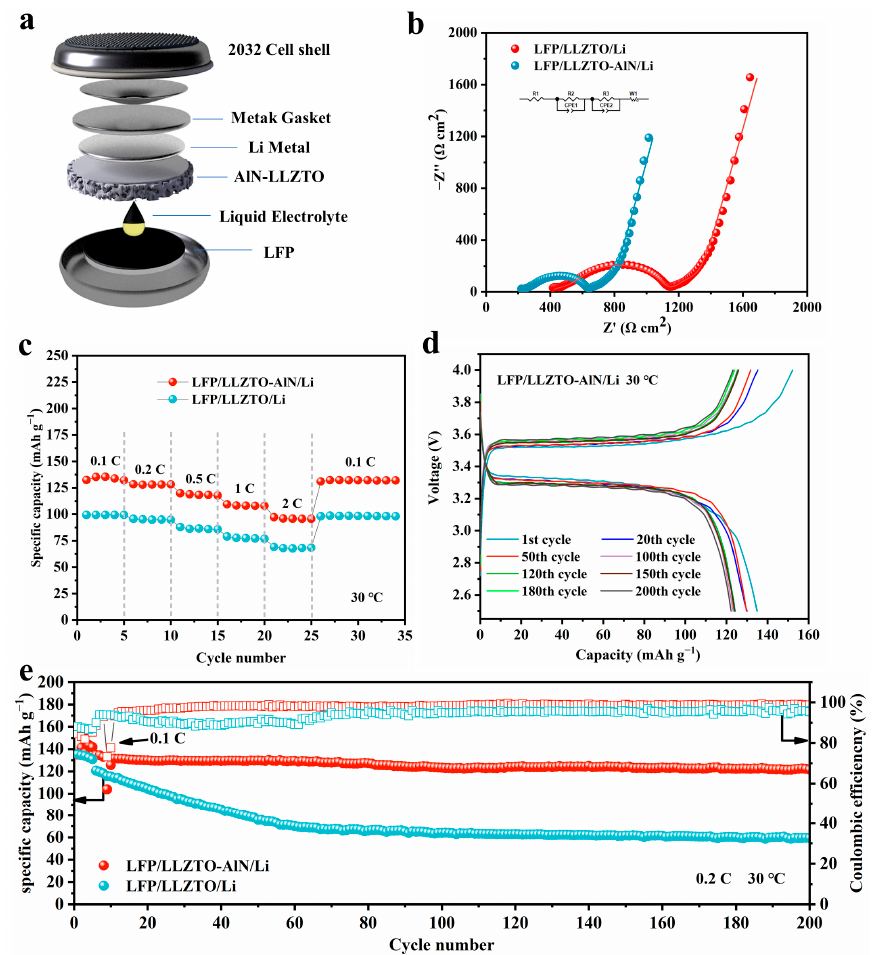
Figure 5. ( a ) Schematic configuration of the Li/AlN-LLZTO/LFP cell; ( b ) comparison of the EIS profiles of the cells using LLZTO with and without AlN modification; ( c ) rate performance of the Li/AlN-LLZTO/LFP cell; ( d ) the charge- and discharge-platform information for different cycles at 0.2 C; ( e ) long-term electrochemical performance of the Li/LLZTO/LFP, and the Li/AlN-LLZTO/LFP cell at 0.2